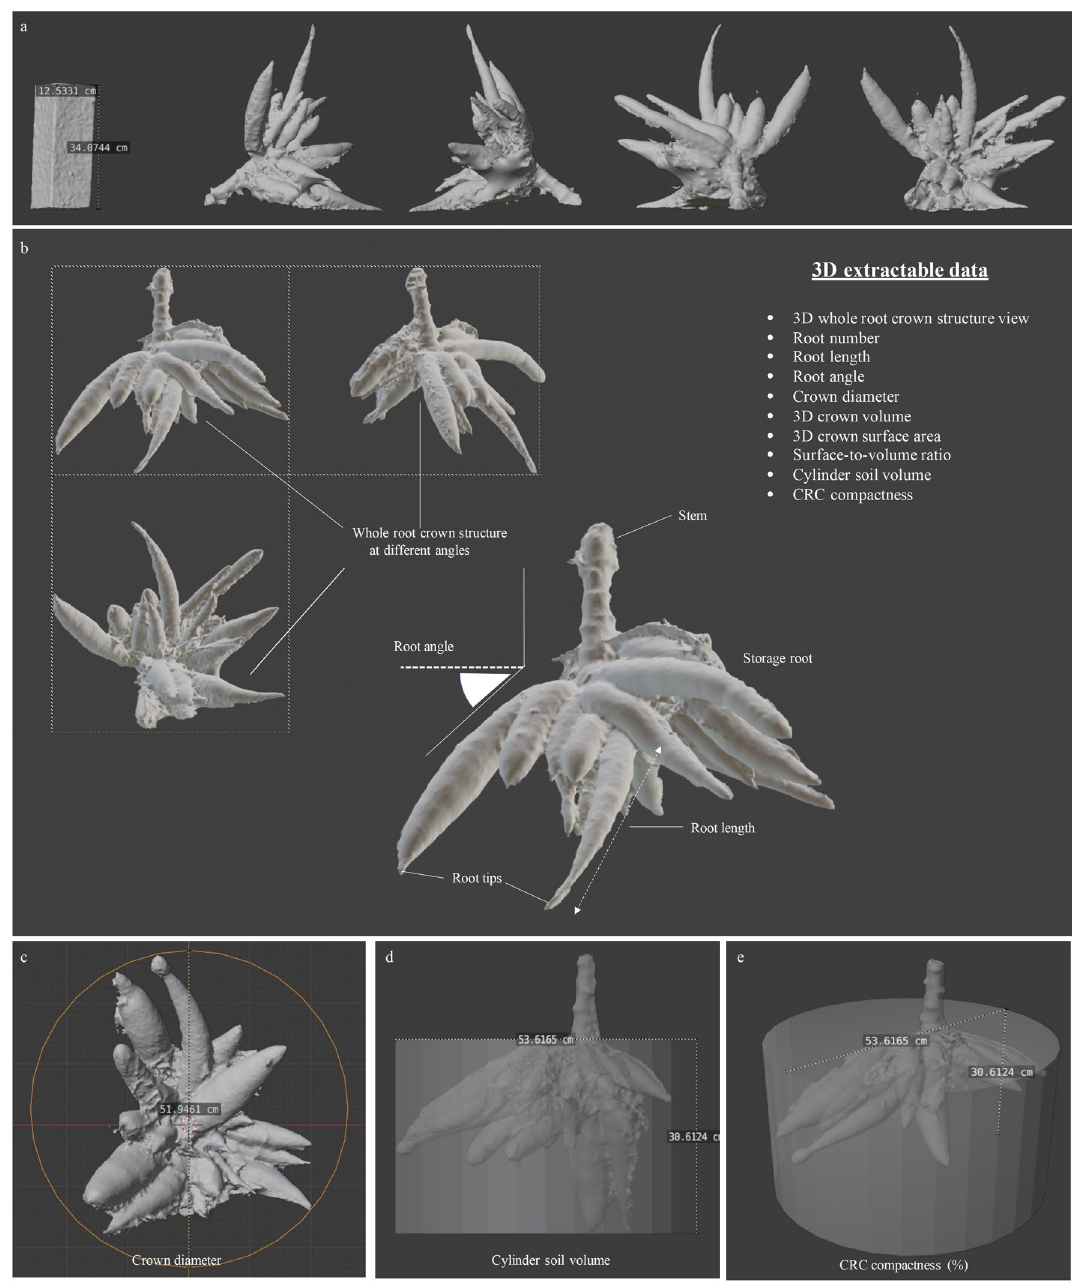
Figure 4. Representative of 3D root crowns in Blender environment for data analysis (Blender 2.90.1: http:// www. blend er. org). ( a ) Directional arrangements of a 3D root crown model and a scale calibration using the refence object. ( b ) Extractable 3D traits obtained from the model. ( c ) A measurement of root crown diameter. ( d ) a measurement of cylinder soil volume. ( e ) CRC compactness represents a percentage of a crown volume within a cylinder soil